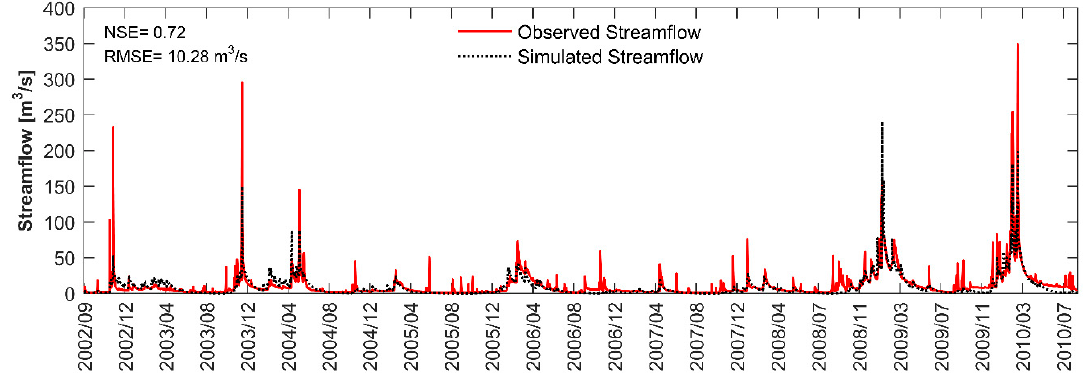
Figure 5. Observed versus simulated daily streamflow using the parameter combinations yielding the best statistical metrics (NSE and RMSE) after validation.